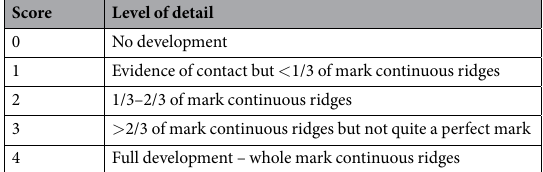
Table 1. Grading scale for fingermark quality 35